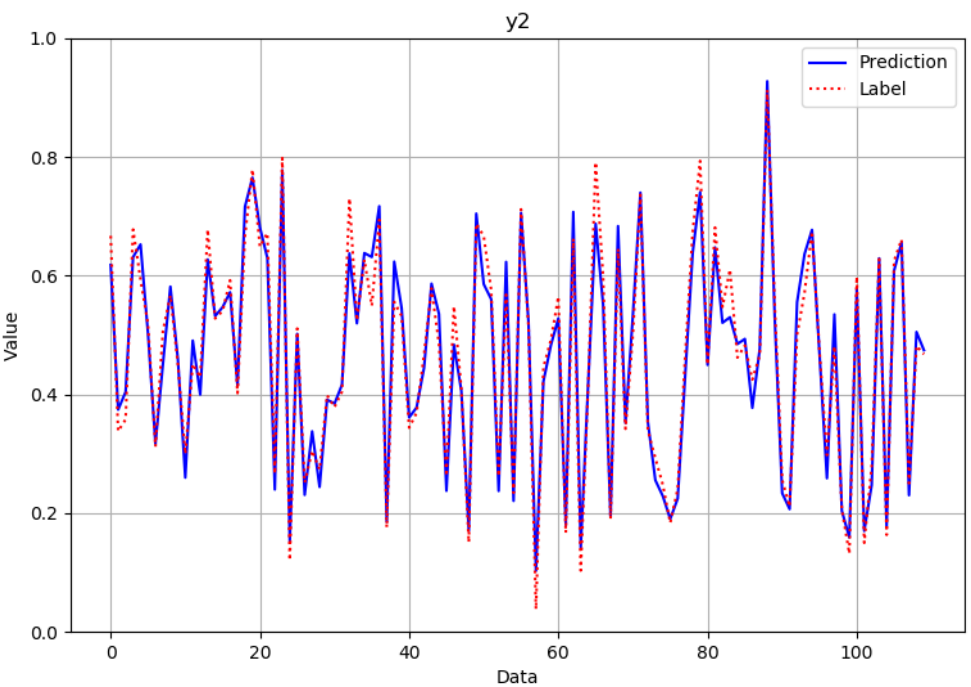
Figure 13. Comparison of predicted and actual values in the fracture strength verification data set after normalization.